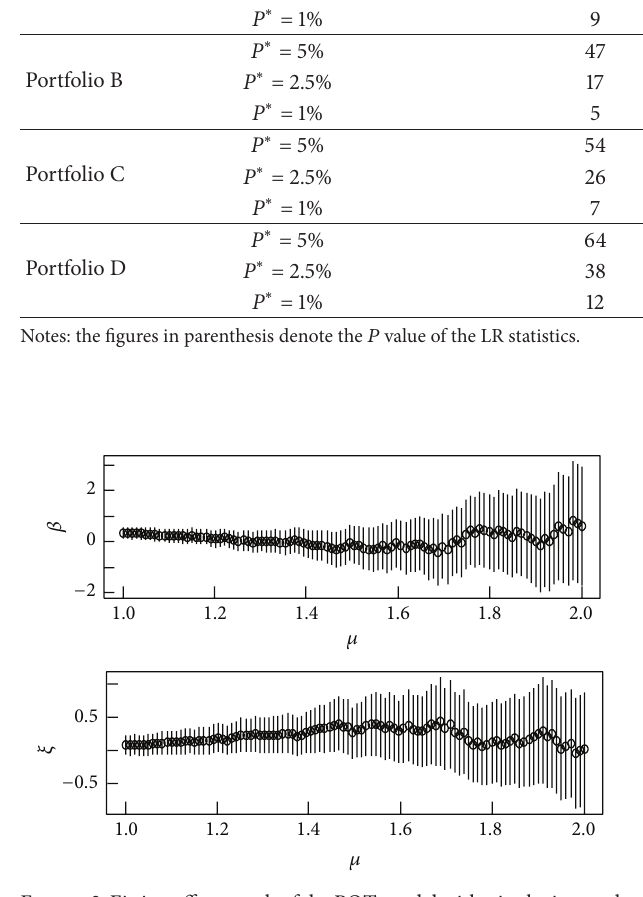
Figure2:FittingeffectgraphofthePOTmodelwith 𝜇 intheinterval (0, 2) for the Futures Portfolio